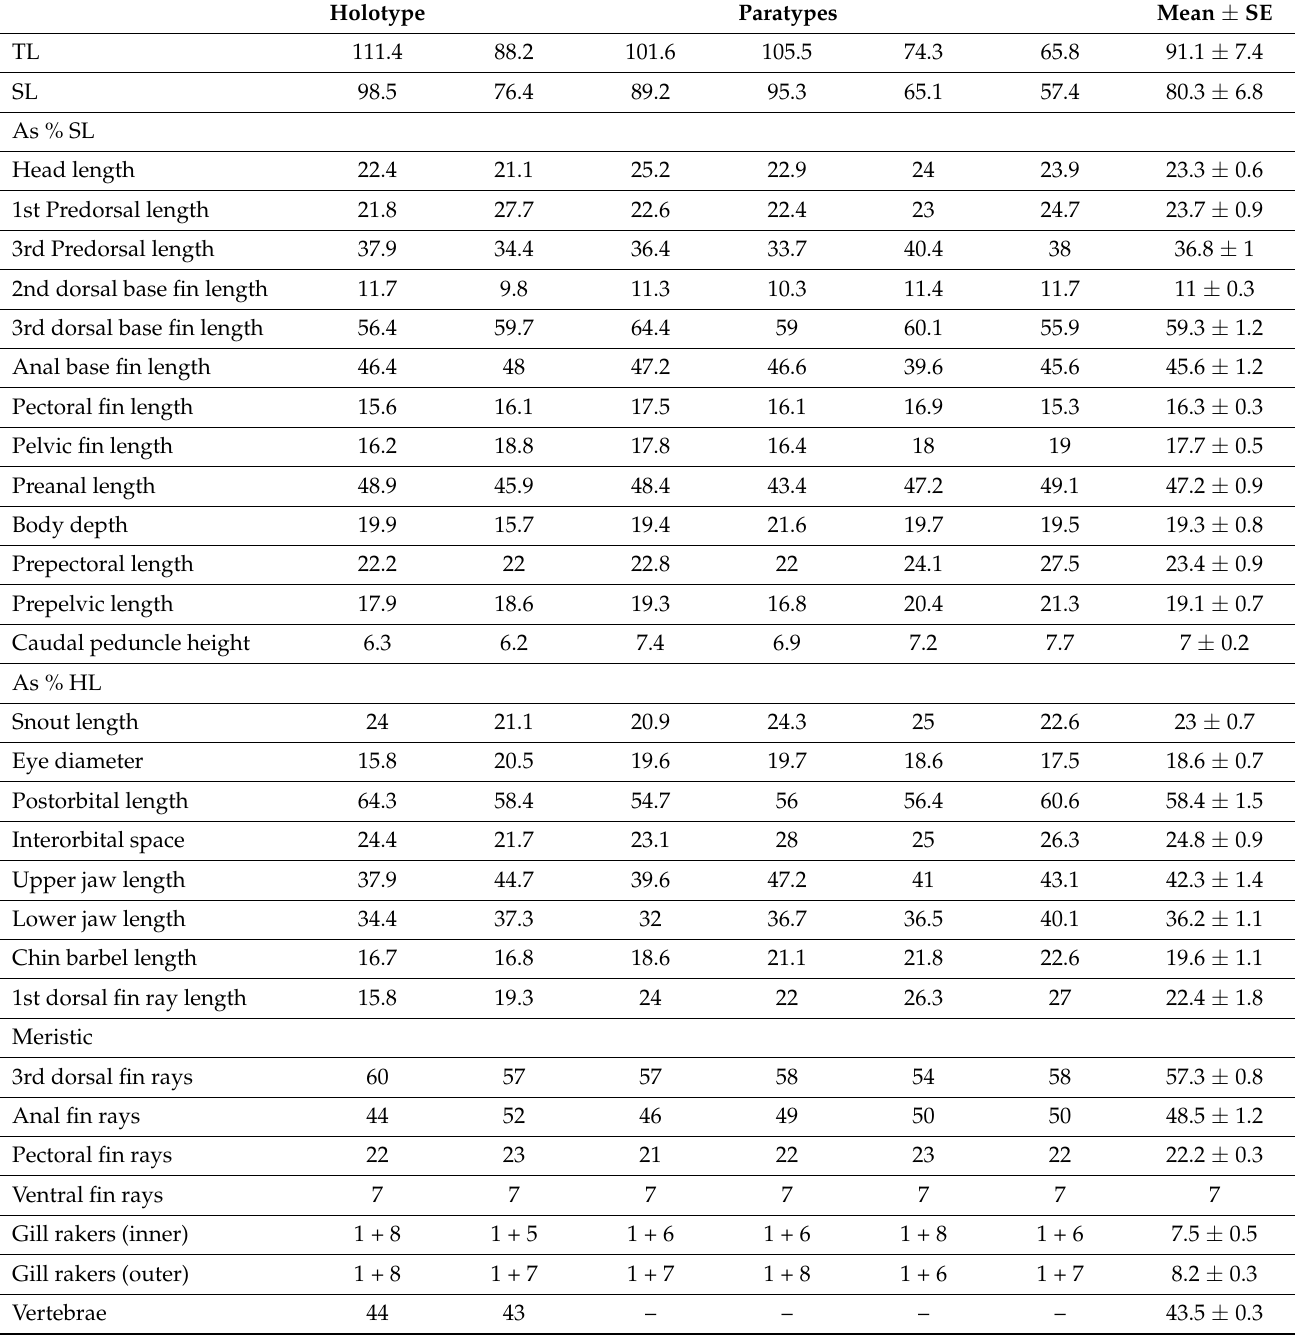
Table 1. Morphological data of the type material of Gaidropsarus gallaeciae sp.